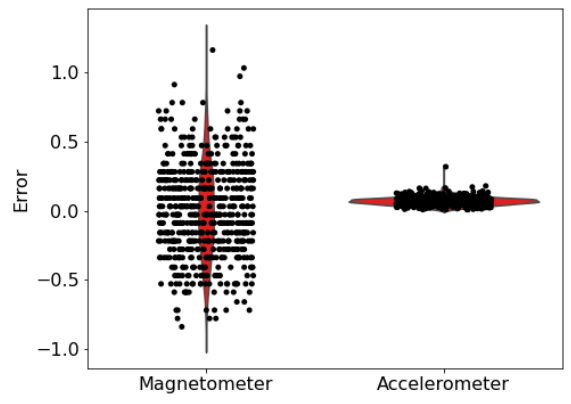
Figure 4. Measurement distribution gathered with 10 different smartphones placed at a constant